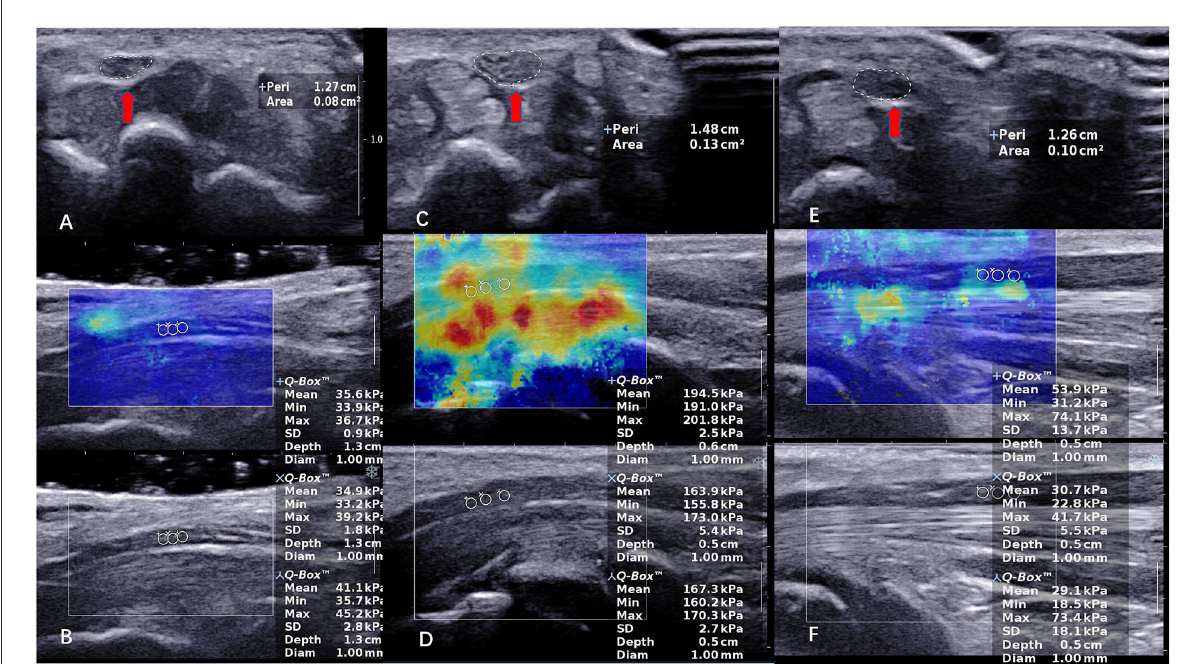
FIGURE1 The CSA and SWE of the median nerve (MN) in a 40-year-old female control subject at carpal tunnel inlet. (A,B) (CSA = 0.08 cm 2 , E mean = 37.2 kPa). The CSA and SWE of the median nerve (MN) in a 51-year-old female patient with severe CTS at carpal tunnel inlet in preoperative. (C,D) (CSA = 0.13 cm 2 , E mean = 175.3 kPa). The CSA and SWE of the median nerve (MN) in a 51-year-old female patient with severe CTS at carpal tunnel inlet in postoperative. (E,F) (CSA = 0.10 cm 2 , E mean = 37.9 kPa). The red arrow indicates the CSA of the